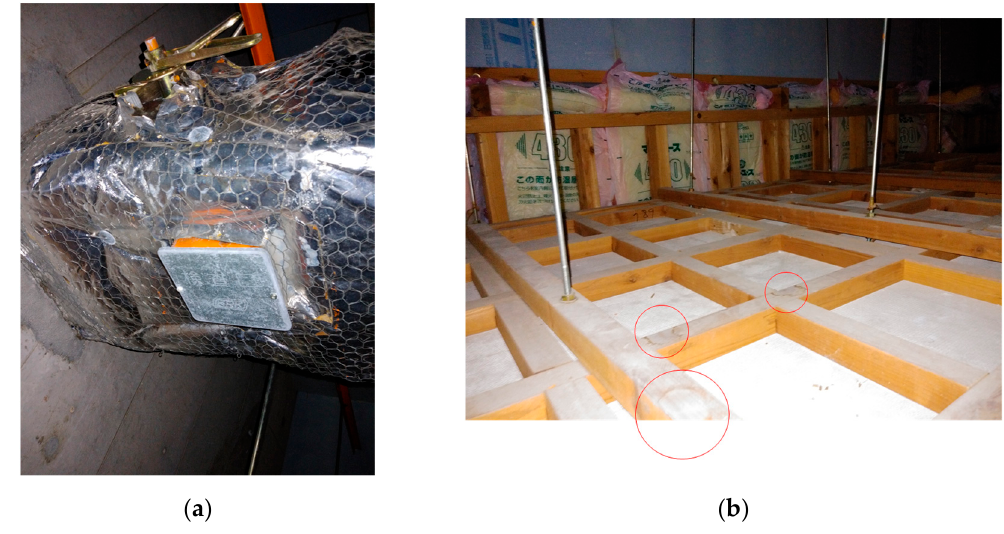
Figure 3. Traces of condensation on the duct surface: ( a ) gaps in the aluminum foil wrapped around the duct, through which water vapor may enter; ( b ) water stains on the ceiling caused by condensed water falling from the duct. Table 1. Specification of the Onset UX100-011.